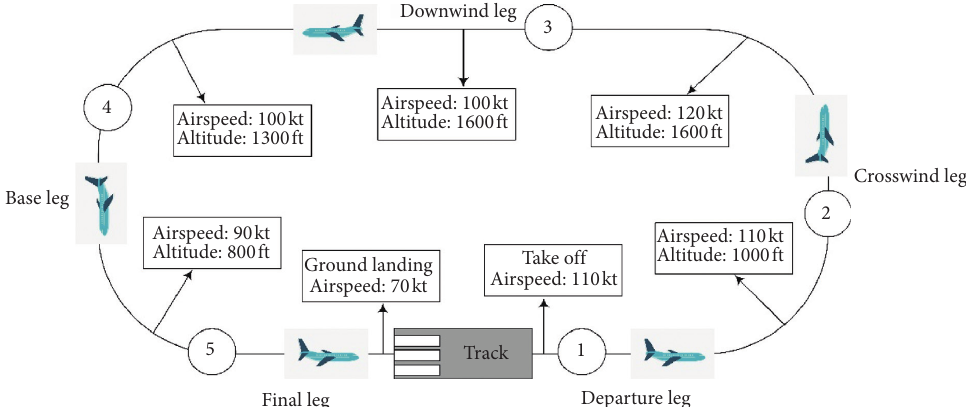
Figure 5: Cessna 172 flight schematic of the airfield traffic pattern.